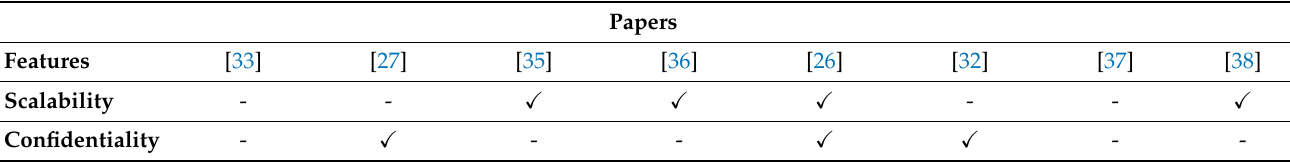
Table 1. Comparative analysis against different features.